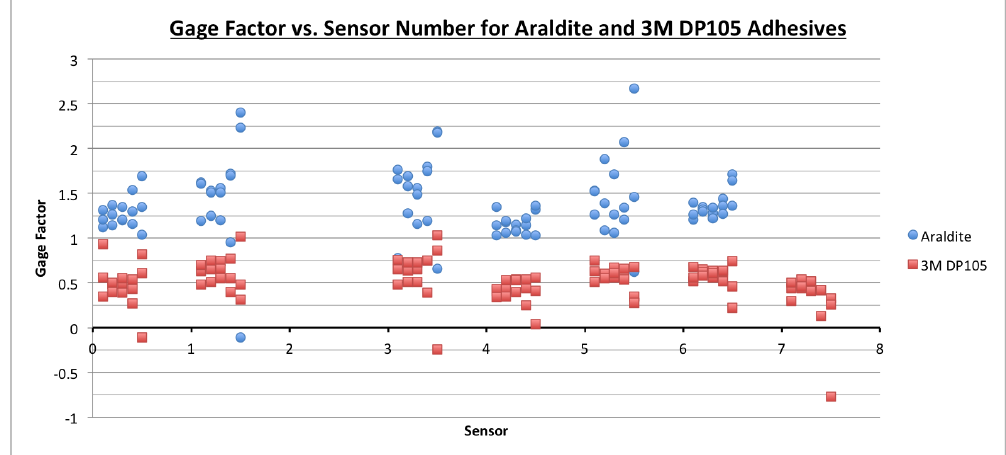
Figure 16. Apparent gage factors determined on individual sensors of sensing sheet prototypes glued with Araldite and 3M DP105 adhesives.